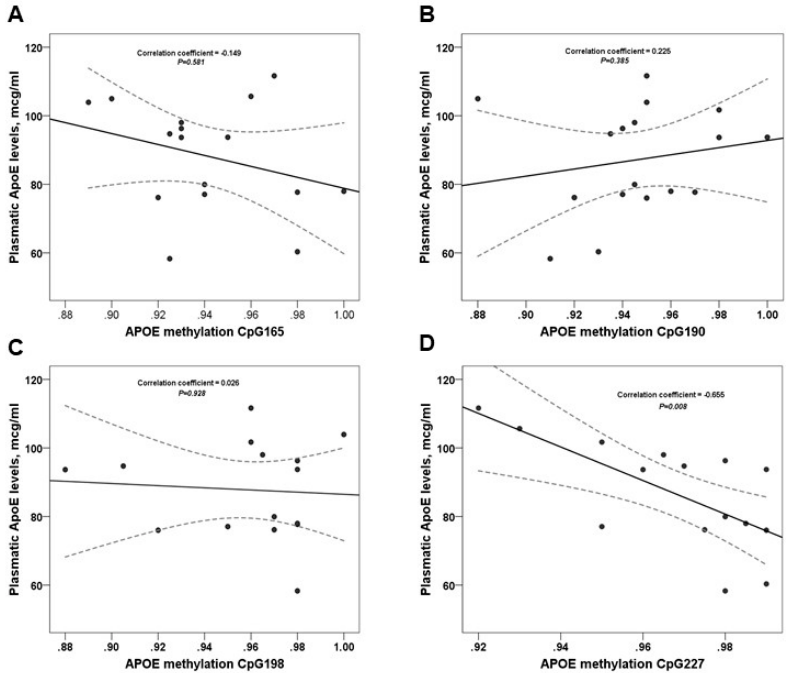
Figure 2. Correlation between Plasmatic ApoE levels and APOE Methylation CpGs. The correlation coefficient and p values for ( A – C ) were calculated using Pearson’s test; and for ( D ) we used the Spearman’s rank correlation.